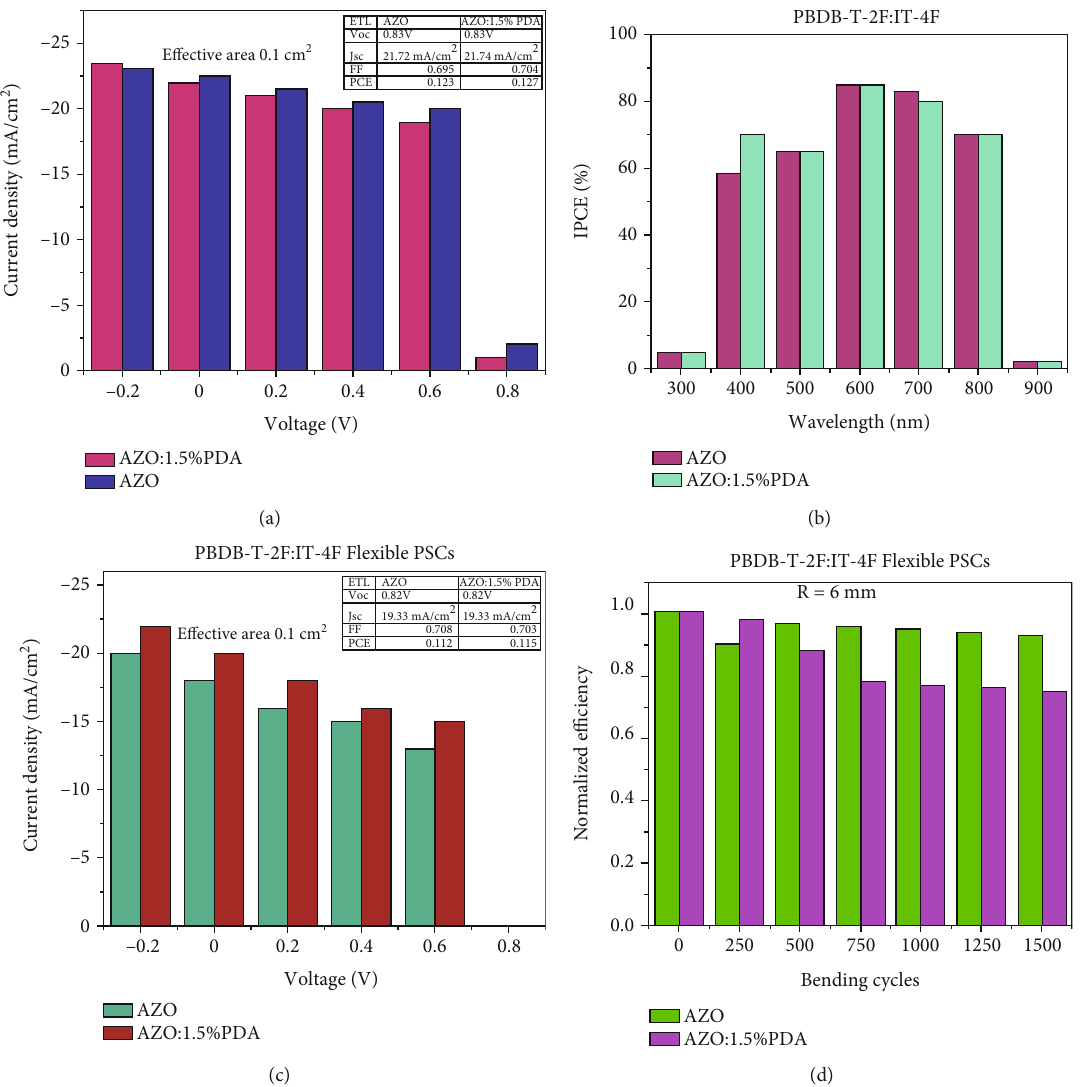
Figure 3: Device characteristics. (a) J – V curves. (b) IPCE spectra of inverted PSCs. (c) J – V curves of fl exible devices. (d) Normalized average PCE of fl exible